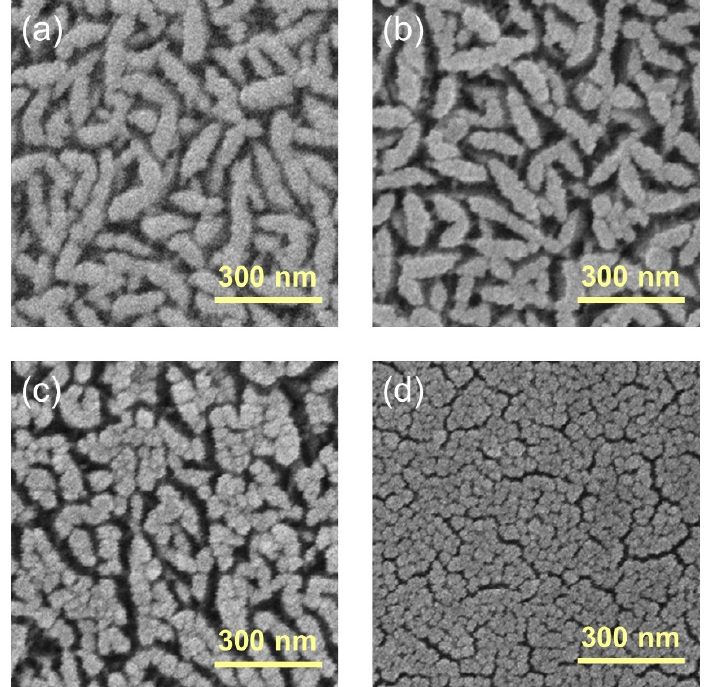
Figure 3. Deformations of nanowalls according to the annealing temperature. SEM images of ( a ) as grown, ( b ) 200 °C rapid thermal annealing (RTA) treatment, ( c ) 300 °C RTA treatment, and ( d ) 400 °C RTA treatment samples.